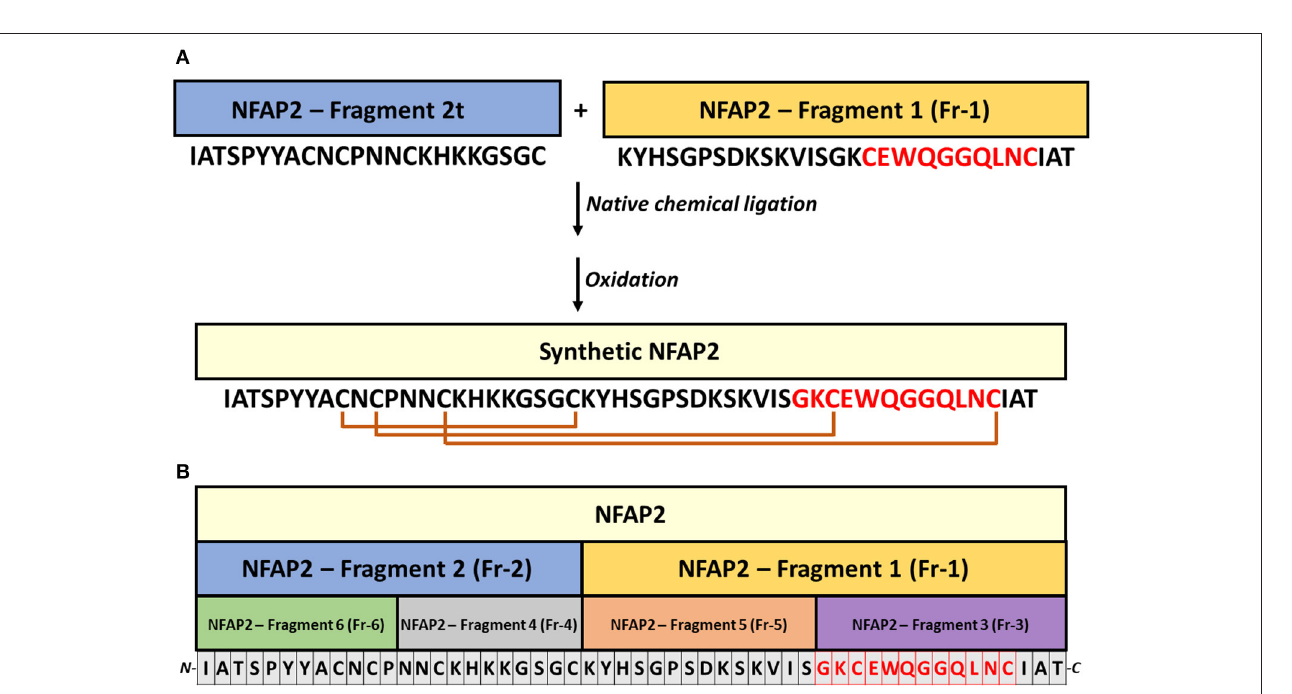
FIGURE 3 | Synthesis strategy of NFAP2 and its peptide fragments. (A) Two synthetic peptides, Fragment 2t (thioester form), and Fragment 1, were linked by native chemical ligation (Váradi et al., 2013) to produce full-length synthetic NFAP2. (B) The synthetized peptide fragments for functional mapping cover the full-length protein. Intramolecular disulphide bridges between cysteines are marked with orange lines and the γ -core motif in red